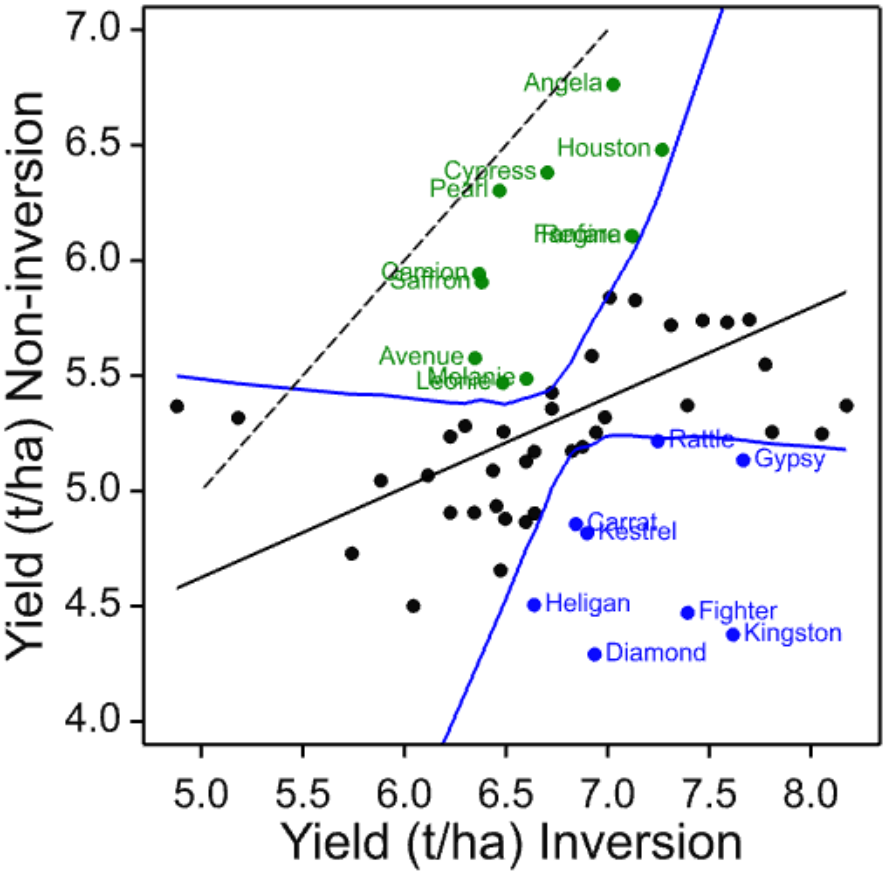
Figure 9. Regression of non-inversion yield on inversion yield for 56 winter barley cultivars in the 2008 trial. The blue lines show the 95% confidence interval of the regression line (solid black), while the dashed line shows the 1:1 yield ratio. Only cultivars outside the confidence limits are labelled for clarity, blue below and green above. Table 9. Absolute yield rank differences for the 2008 trial. Number of cultivars shows the number of cultivars with the given rank change and Cumulative shows the number with that rank change or greater. The 50%, 90% and 95% points are from the simulated variables and show the distribu- tion of the number of cultivars that exhibited an absolute rank change at least as large as that speci fi ed due to random variation, as described in the text.